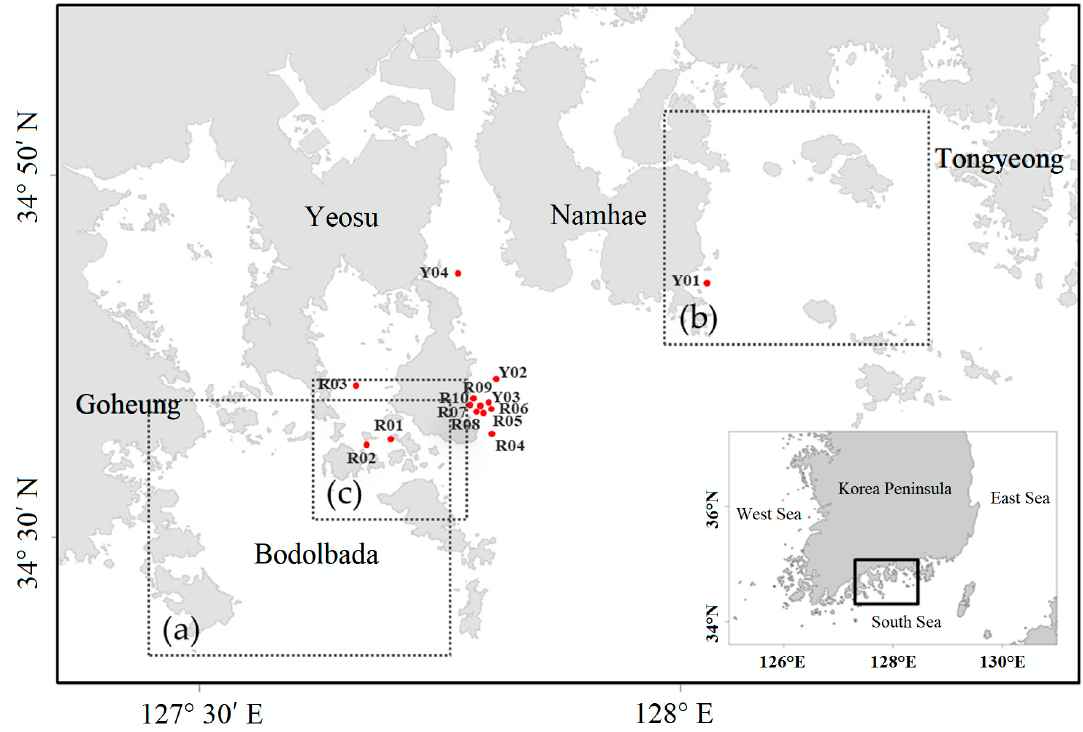
Figure 1. The study area used for identification of synergistic effects of multi-sensor data. Red dots indicate in situ sampling locations where chlorophyll concentration (CHL), the spectrum of surface waters, and cell abundance were measured. Images from various sensors were obtained on ( a ) 29 July 2018, ( b ) 30 July 2018, and ( c ) 1 August 2018.